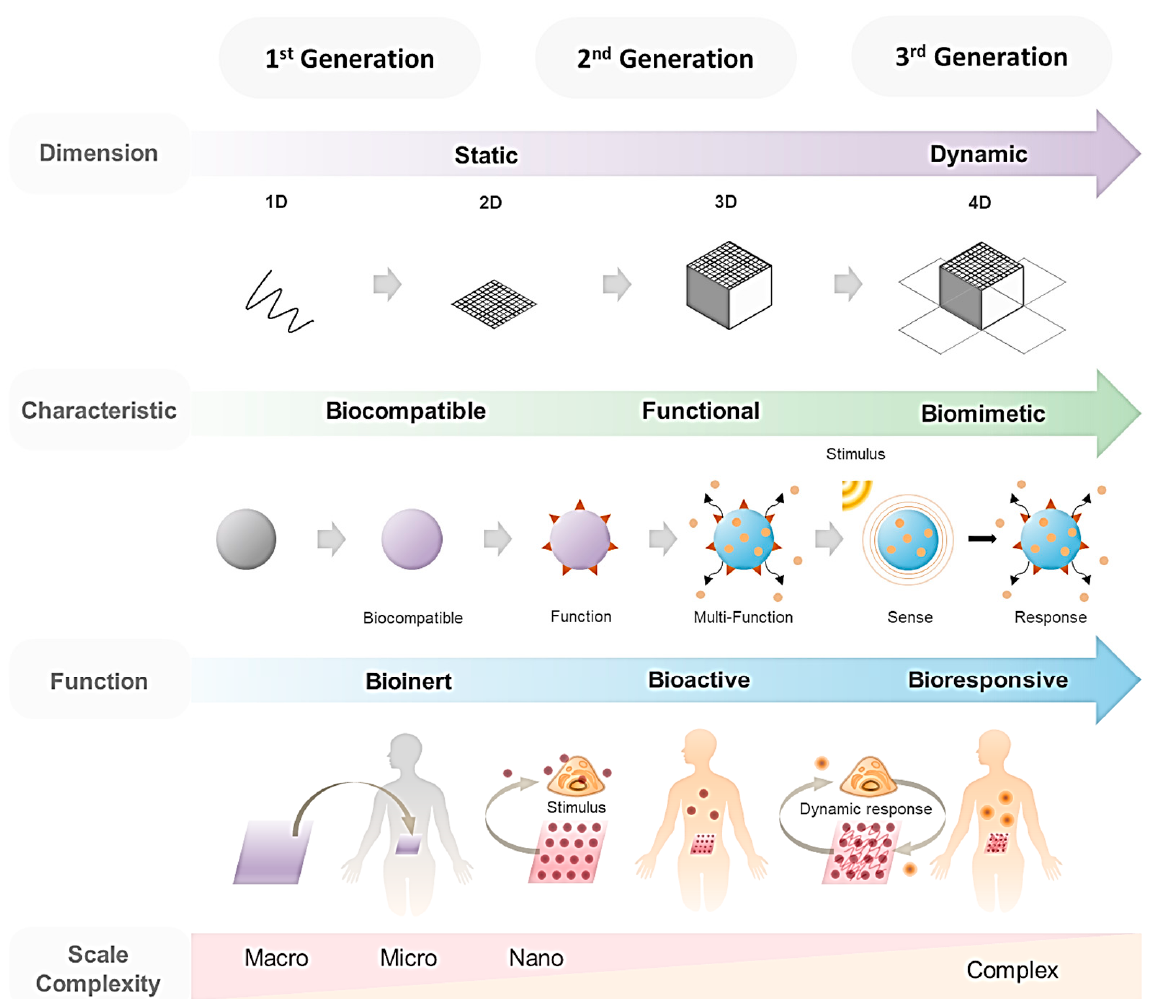
Figure 1. Trends in biomaterials research. Biomaterials can be largely divided into three generations.